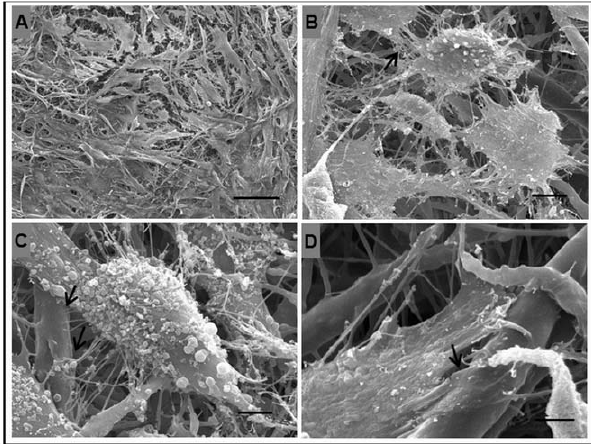
Figure 3. SEM micrographs of the morphology of hASCs cultured for 7 days on the electrospun PHB/PHB-HV fiber mesh. (A) Panoramic view depicting high cell density and spindle- shape morphology, scale bar: 100 m m; (B) arrow indicate the interaction between two and more cells, scale bar: 10 m m; (C–D) arrows indicate the interaction of hASCs with the fibers, scale bar: 5 m